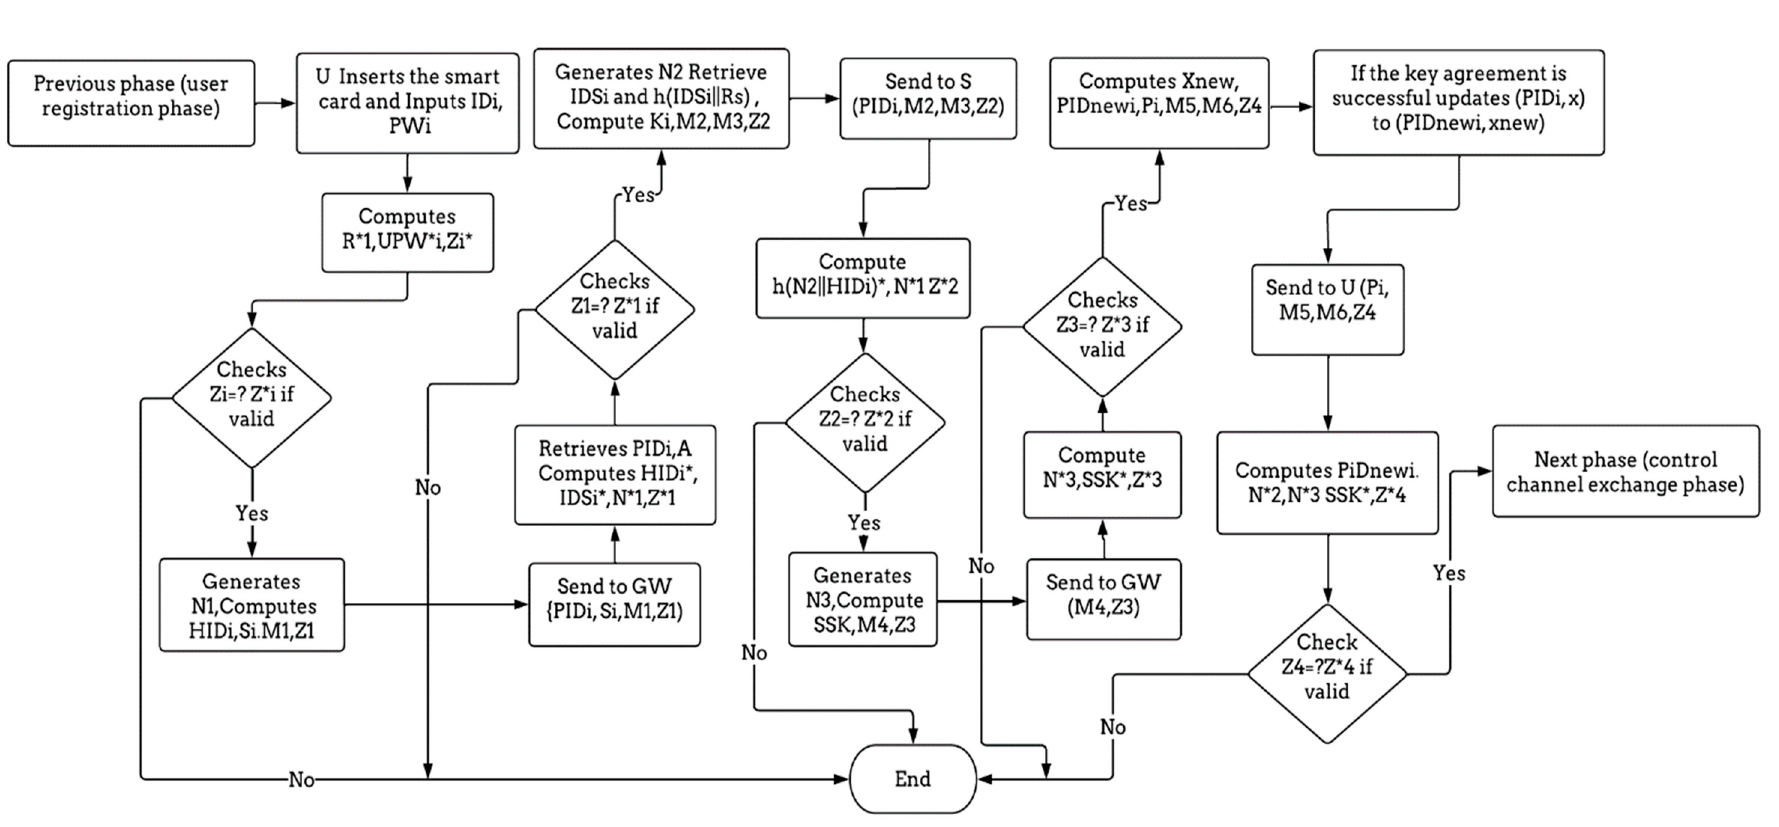
Figure 5. The flow diagram of the login and authentication phase.